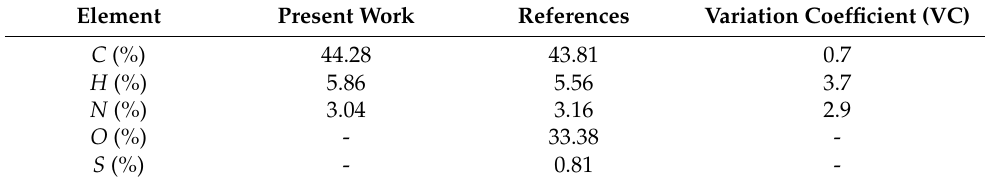
Table 2. Ultimate analysis results and comparison.